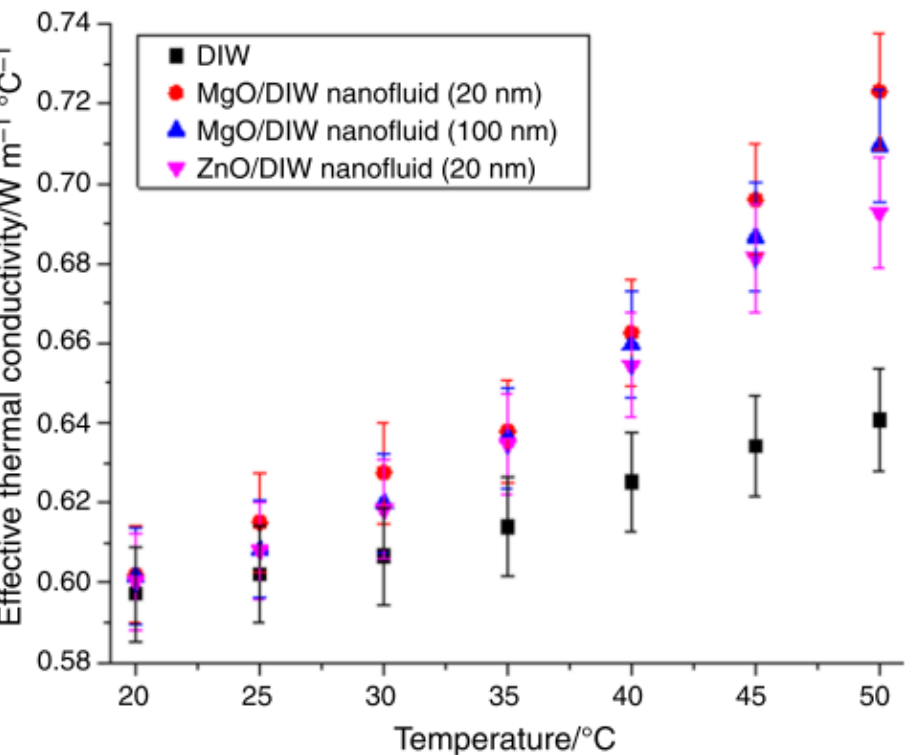
Figure 6. Effect of increasing temperature on effective thermal conductivity of nanofluids with different nanoparticle size [43].